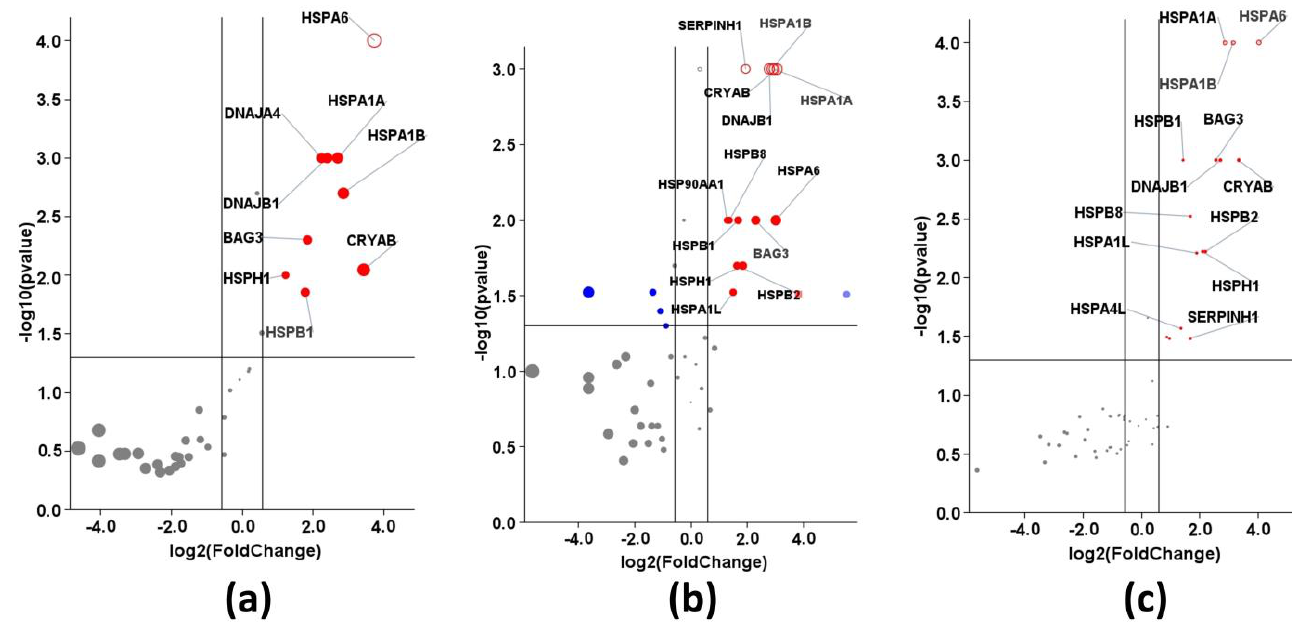
Figure 3. Volcano plots for ( a ) Daoy cells ( b ) SH-SY5Y cells ( c ) Differentiated SH-SY5Y cells: Log 2 fold-changes in gene expression between 0 h (completion of heat stress exposure) and control are plotted against t -test p -values. A higher position indicates higher statistical significance, and a position farther from the central axis means larger gene expression changes. Some of the very significant genes are labeled. Table 2. Classification of overexpressed genes according to Heat Shock Protein or Chaperone Family. Chaperone